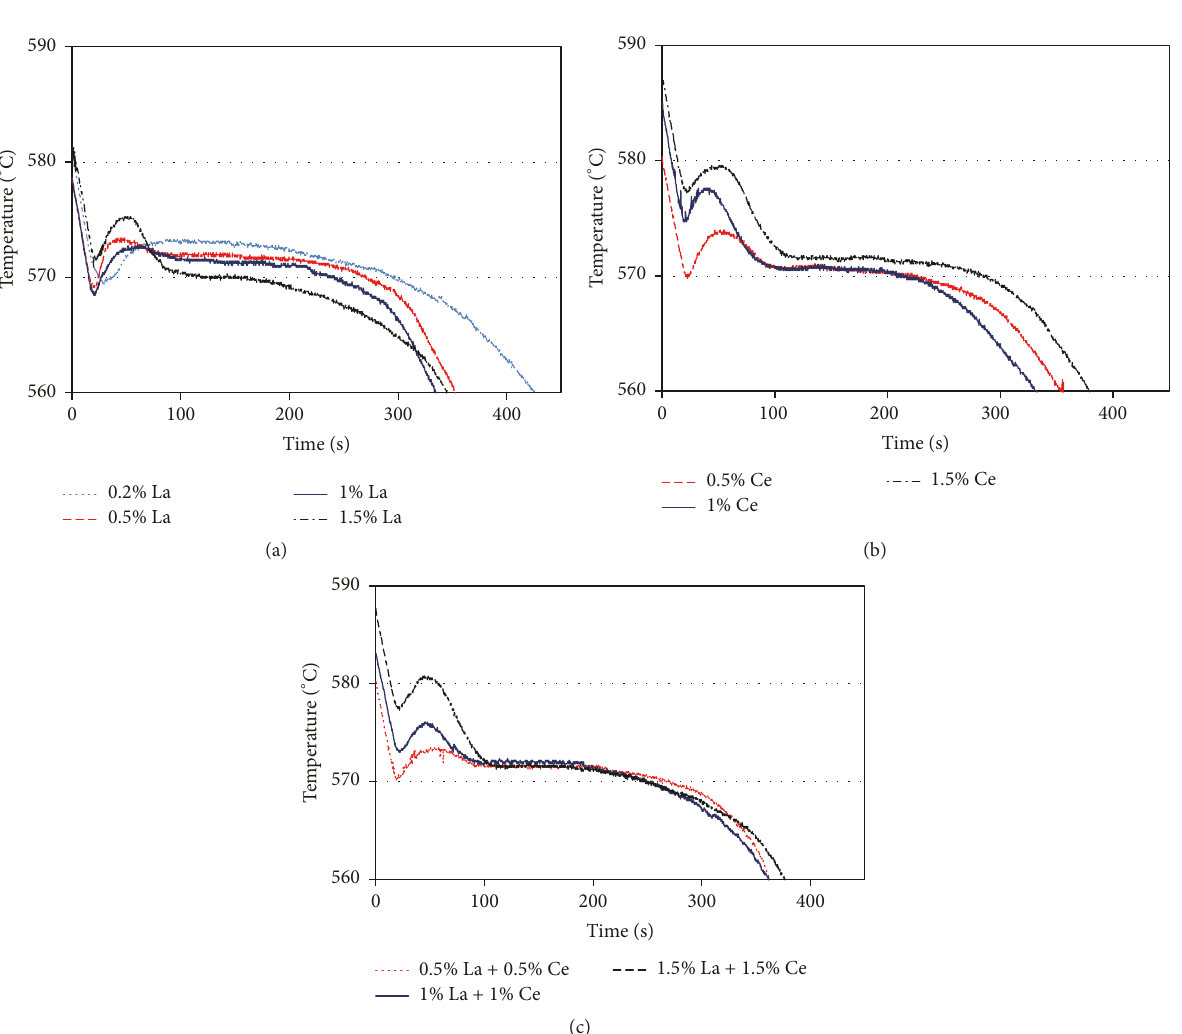
Figure 4: Temperature-time curves obtained from the base alloy with various concentrations of (a) La, (b) Ce, and (c) La +